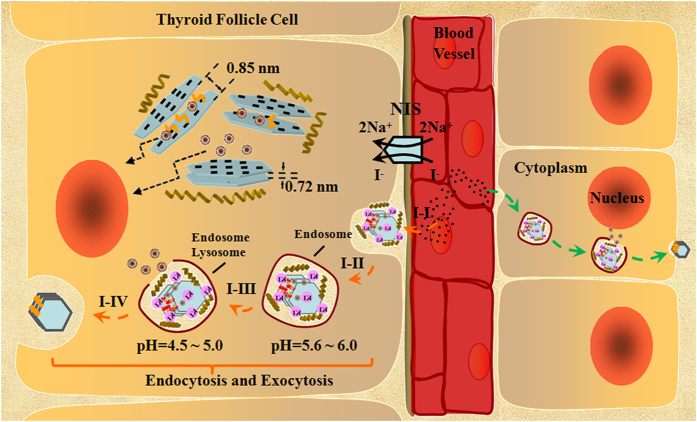
Delivery mechanism.Schematics illustration of the mechanismof the intracellular delivery of DOX by KI@DOX-KaolinMeOH.